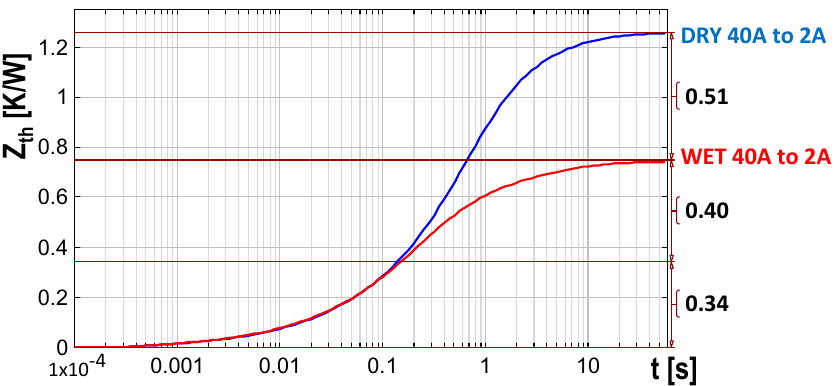
Figure 7. Z th curves, component on cold plate at “dry” and “wet” boundary conditions (from [11]).